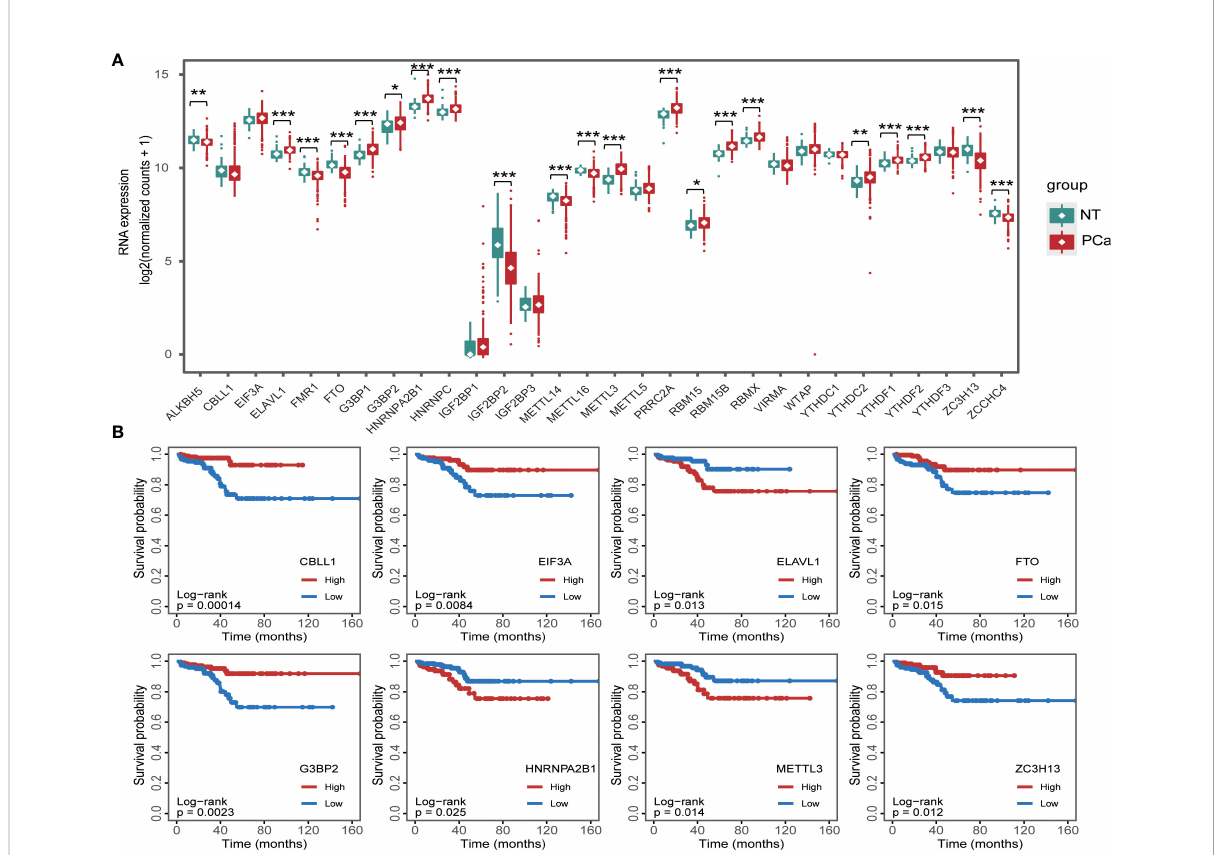
FIGURE 1 RNA m6A regulator expression in prostate cancer (A) and its relationship with progression-free interval (B) . *p < 0.05, **p < 0.01, ***p <